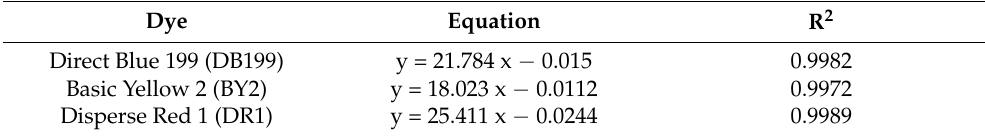
Table 6. Lambert-Beer line equations and R 2.